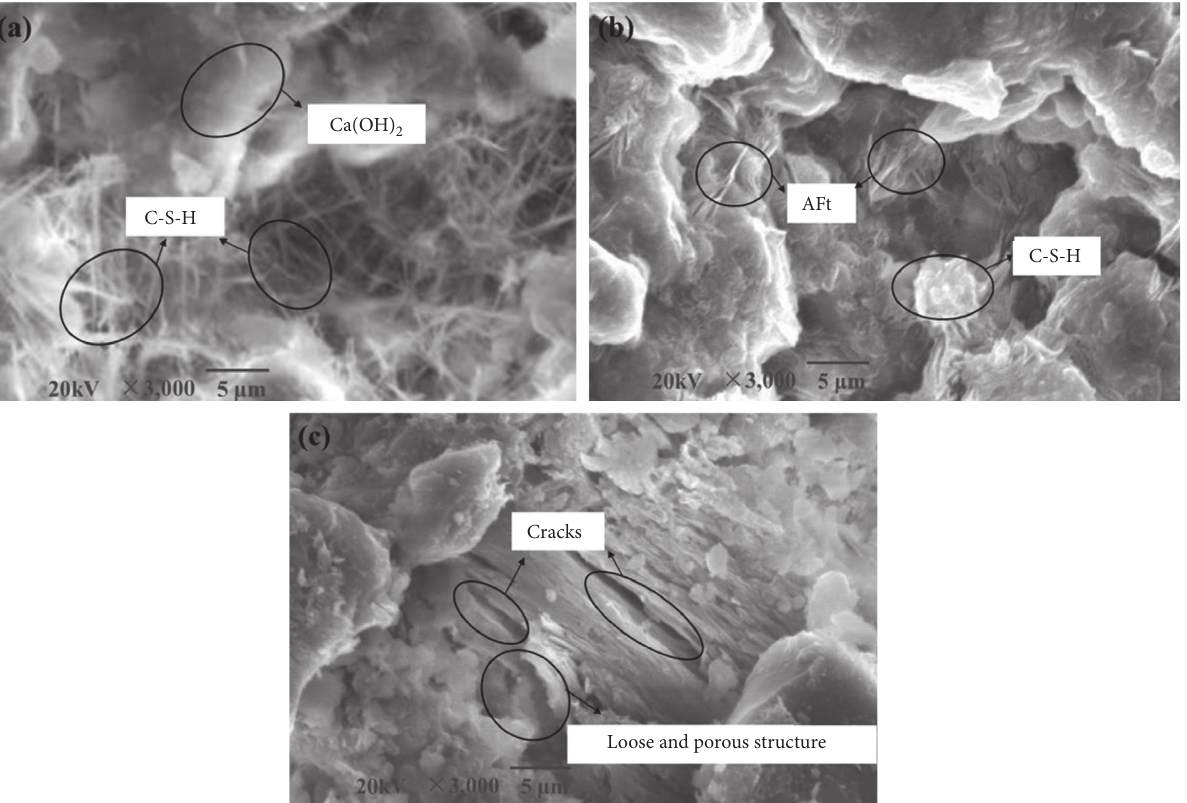
Figure 12: SEM results of Cr-contaminated soil stabilized with C6S24 under different numbers of wetting-drying cycles: (a) 0, (b) 3, and (c)